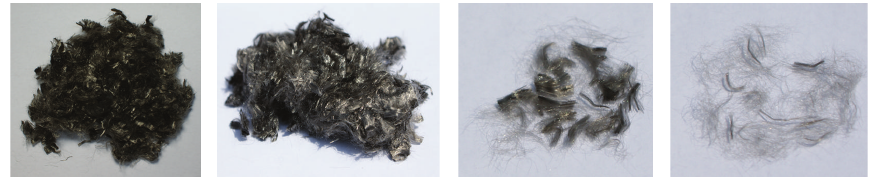
Figure 2: Picture of short polypropylene fibers.